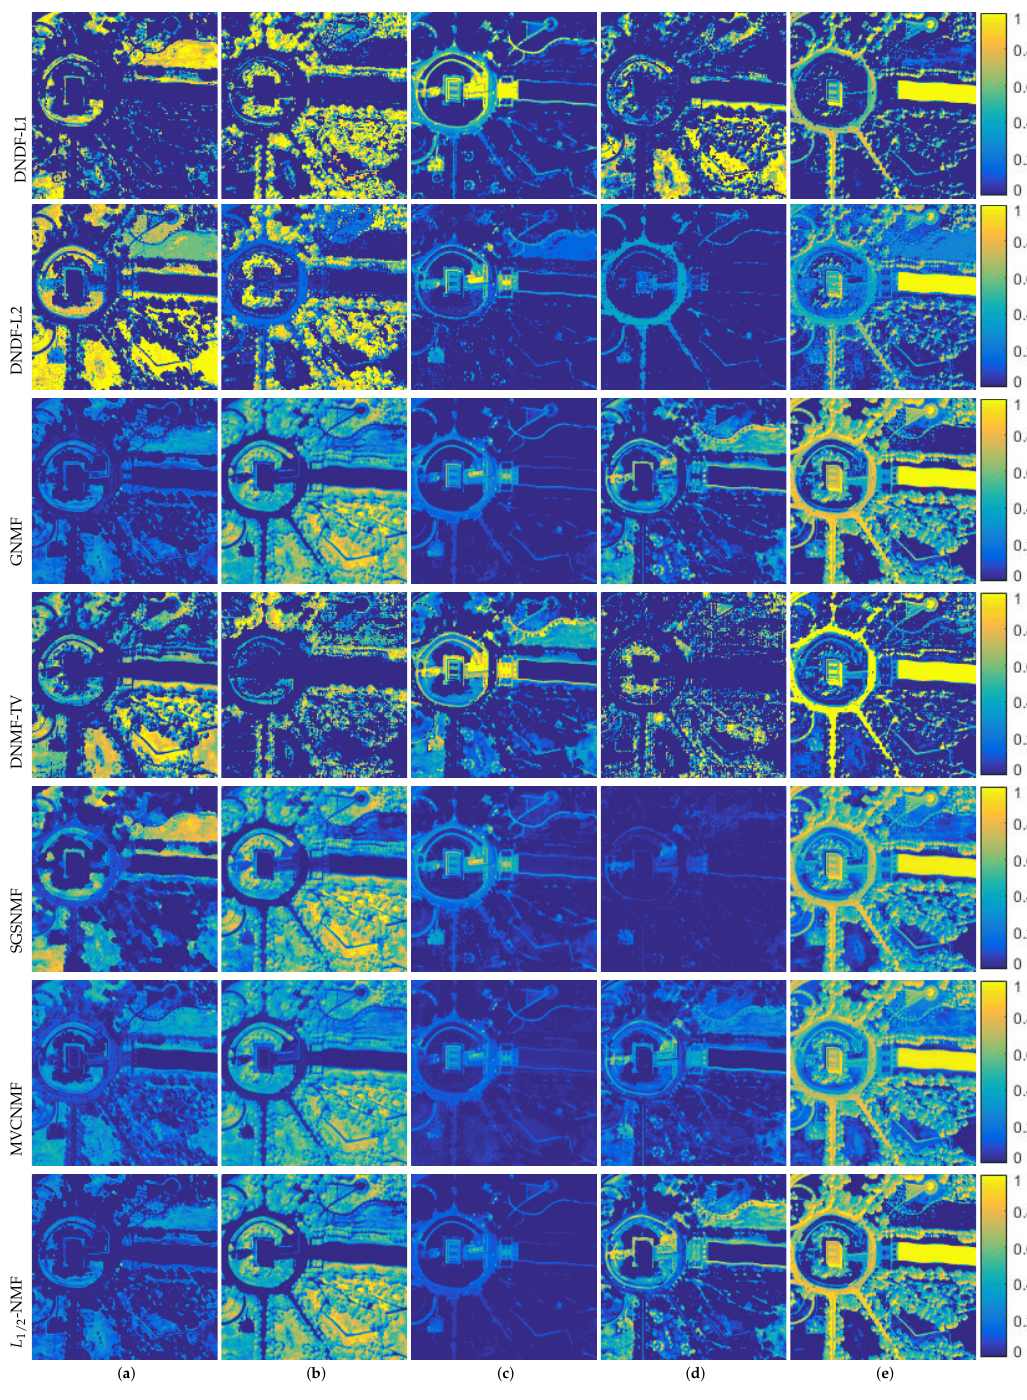
Figure 4. Abundance maps estimated by DNDF-L1, DNDF-L2, GLNMF, SDNMF-TV, SGSNMF, MVCNMF, L 1/2 -NMF on Washington DC Mall . ( a ) Grass; ( b ) Tree; ( c ) Roof; ( d ) Street; ( e )